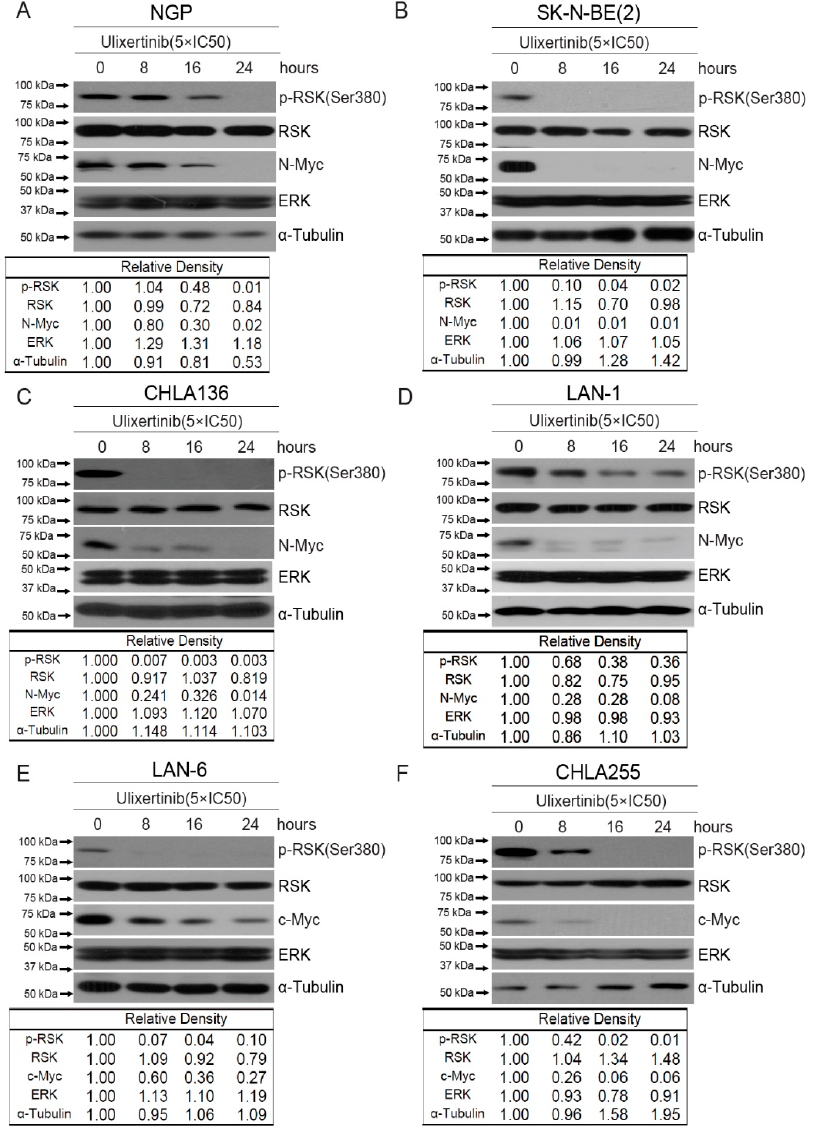
Figure 2. Ulixertinib suppresses ERK activation and reduces MYC/N-MYC levels in NB cells. Six NB cell lines, NGP ( A ), SK-N-BE(2) ( B ), CHLA136 ( C ), LAN-1 ( D ), LAN-6 ( E ), and CHLA255 ( F ) were treated with indicated doses of ulixertinib for variable periods (0 h, 8 h, 16 h, and 24 h). The proteins were extracted and subjected to SDS-PAGE for immunoblotting with the antibodies indicated. Gel densitometrical analysis was performed using ImageJ software (Version 1.52a, accessed on 23 April 2018) (Wayne Rasband, National Institutes of Health,